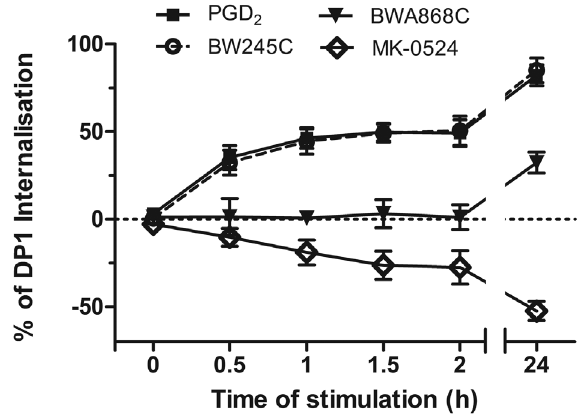
Figure 4. MK-0524 promotes cell surface expression of DP1. Cell surface expression of the receptor was measured by ELISA as described under ‘‘Materials and Methods’’ in HEK293 cells transiently expressing Flag-DP1 incubated for the indicated times with 1 m M of PGD 2 , BW245C, BWA868C or MK-0524. The results are shown as the percentage of cell surface expression of Flag-DP1 in cells stimulated with the ligands compared with cells treated with control vehicles. Results are the mean 6 S.E. of at least four independent experiments.